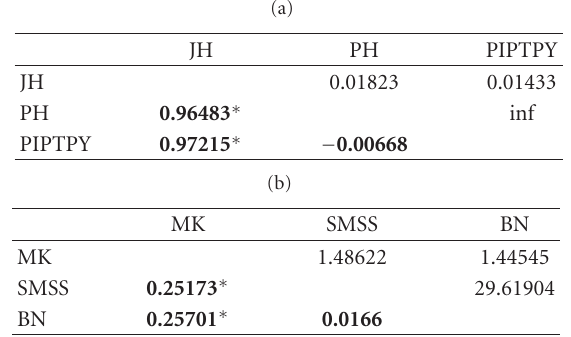
Table 2: F st (bold values) and Nm (light values). JH, B. japonicus from the Sagami Bay; PH, B . platifrons from the Sagami Bay; PIPTPY, B . platifrons from the Okinawa Trough; MK, B . marisindi- cus from the Kairei Field; SMSS, B. septemdierum from the Myojin Knoll and the Suiyo Seamount; BN, B . brevior from the North Fiji